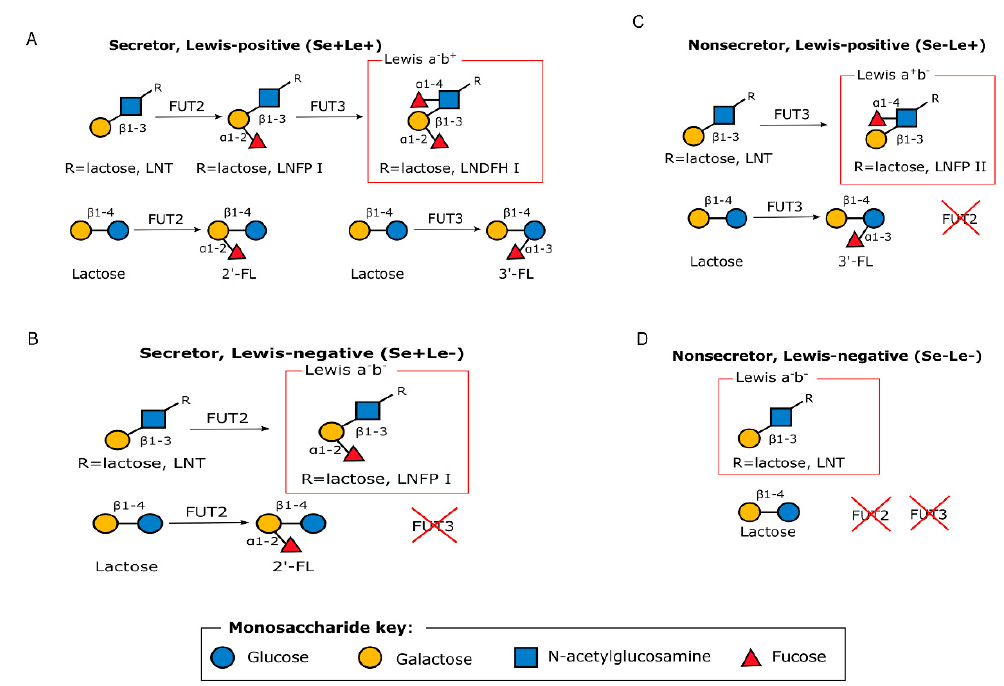
Figure 1. Graphical representation of the enzymatic processes that lead to the different HMO phenotypes. Adapted with permission from Bode 2012 [41]. ( A ) Secretor, Lewis-positive (Se + Le + ), ( B ) Secretor, Lewis-negative (Se + Le − ), ( C ) Non-secretor, Lewis-positive (Se − Le + ), and ( D ) Non-secretor, Lewis-negative (Se − Le − ) FUT2: Fucosyltransferase 2; FUT3: Fucosyltransferase 3. 2’-FL: 2’-fucosyllactose; 3’-FL: 3’-fucosyllactose.